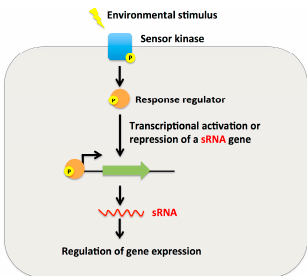
Table 2. CU motifs in sRNA:mRNA interactions in gram-positive